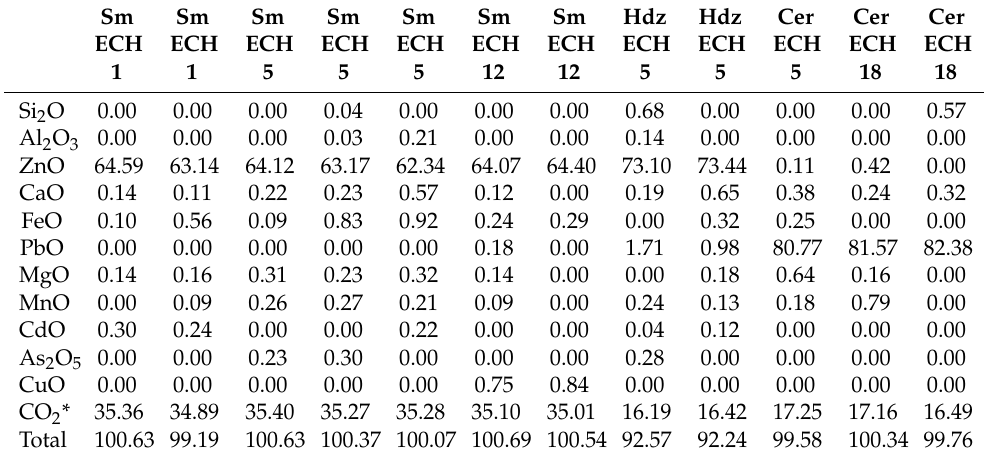
Table 3. Chemical composition of selected Zn-Pb-bearing carbonates from the nonsulfide ore